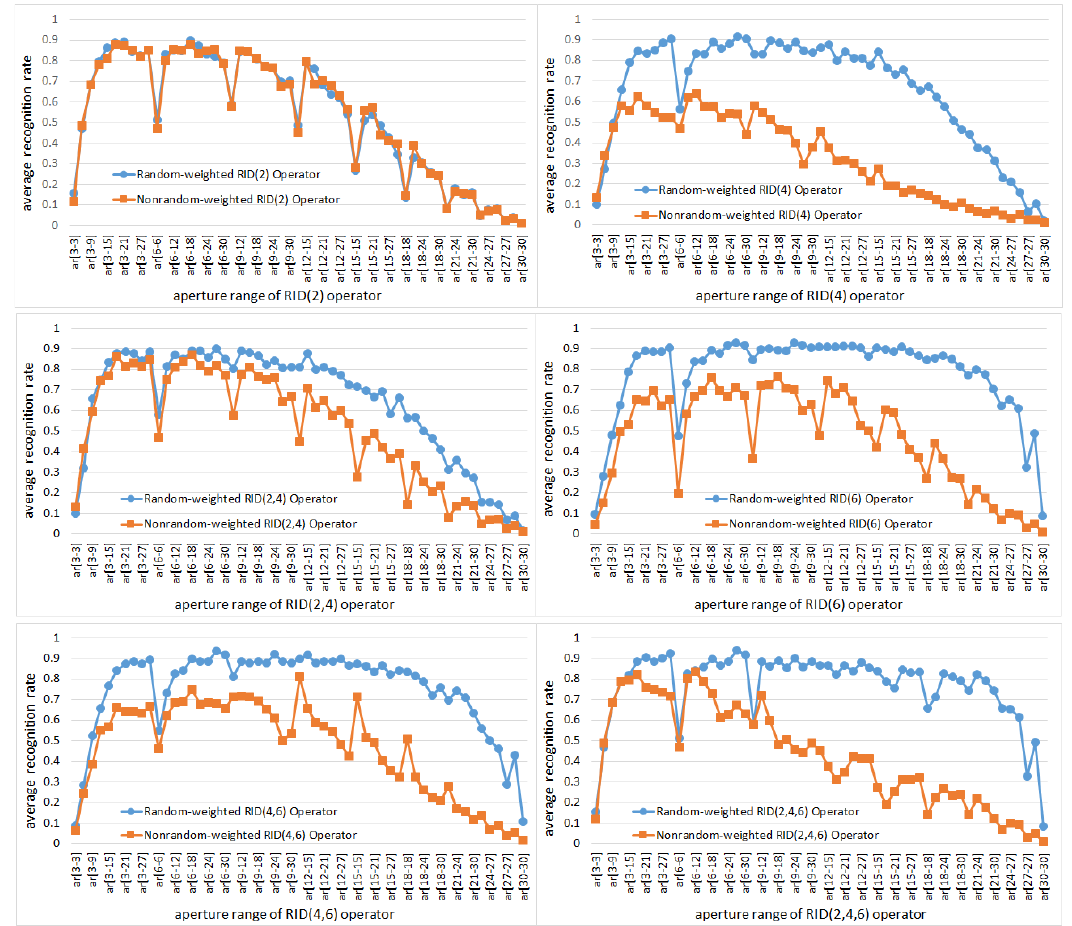
Figure 9. The comparison of recognition rate of random ferns classifier embedded with different RID operators. In each sub-figure two curves are plotted for comparison: one is for random-weighted RID operator, the other is for nonrandom-weighted RID operator. In both cases, recognition rate curves are plotted with respect to the range of operator